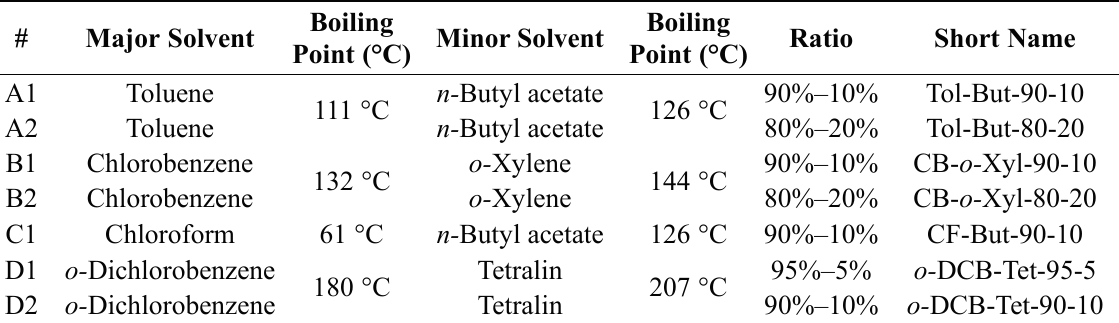
Table 2. List of the shortlisted solvent combinations for experimental part II.